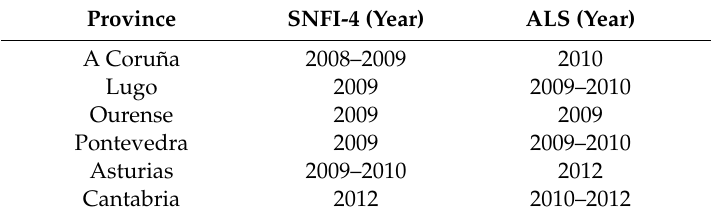
Table 3. Dates of SNFI-4 and ALS surveys carried out in the di ff erent provinces in the study